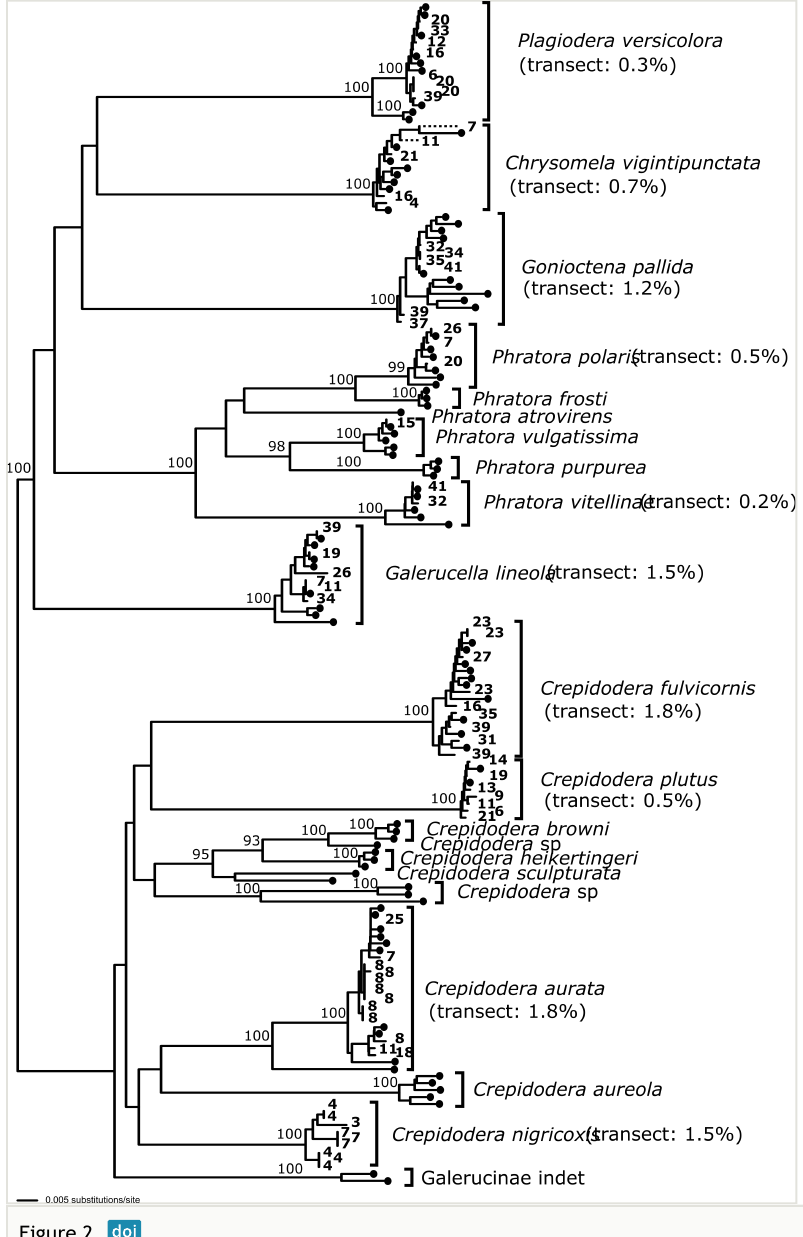
Figure 2. DNA barcoding analysis using COI sequences generated in this study and from GenBank. Sequences from this study show the site number and those obtained from GenBank are indicated by a black circle (GenBank accessions given in Table 3). Node support shown only for nodes > 90% bootstrap support. Maximum intraspecific divergences are shown (for our transect samples only), estimated using uncorrected (p) distances (see